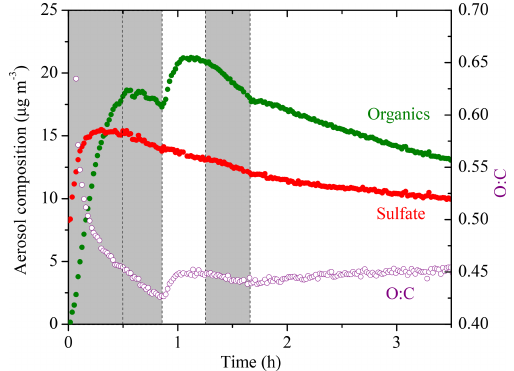
Figure 5. The AMS-measured aerosol composition (CE = 1) (left axis) and the atomic oxygen-to-carbon ratio (right axis) evolving with time for Exp. 1. The increase in the sulfate signal at t = 0 is the result of a change in the collection efficiency (CE). Ozone was added into the chamber at time zero to initiate α -pinene ozonolysis. The shaded areas indicate that the chamber was dark. The dashed lines mark the beginning and the end of the two times HONO were